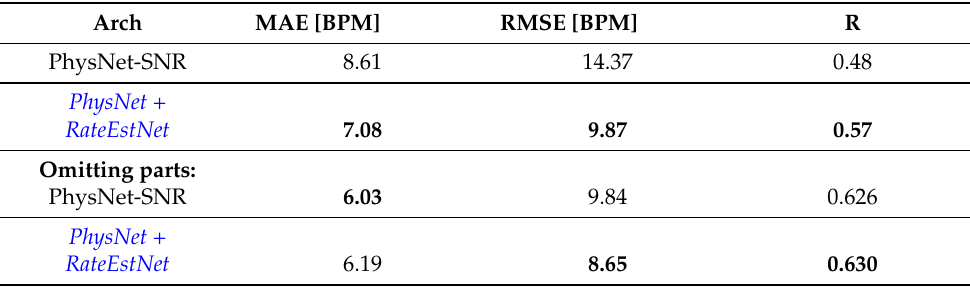
Table 3. Calculated metrics for PhysNet (first row) and for the ensemble of PhysNet and RateEstNet (second row) regarding the whole test set. Italic and blue colored typeface denote our method (Physnet + RateEstNet). At the bottom, the results are shown when omitting parts from the test set where the head of the infant was covered or the illumination level was low (i.e., from 6th to 8th h and from 12th to 13th h, see Figure